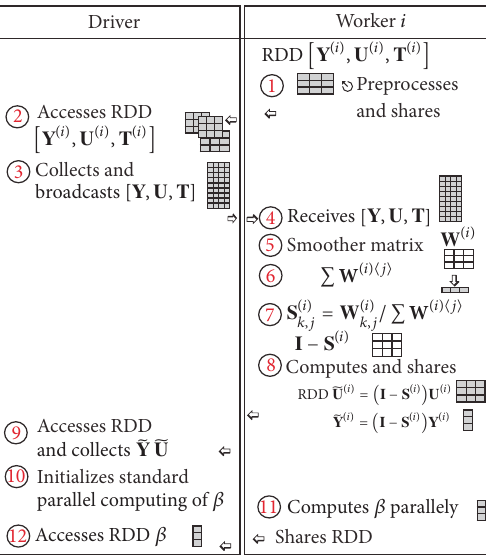
Figure 2: PLM parallel